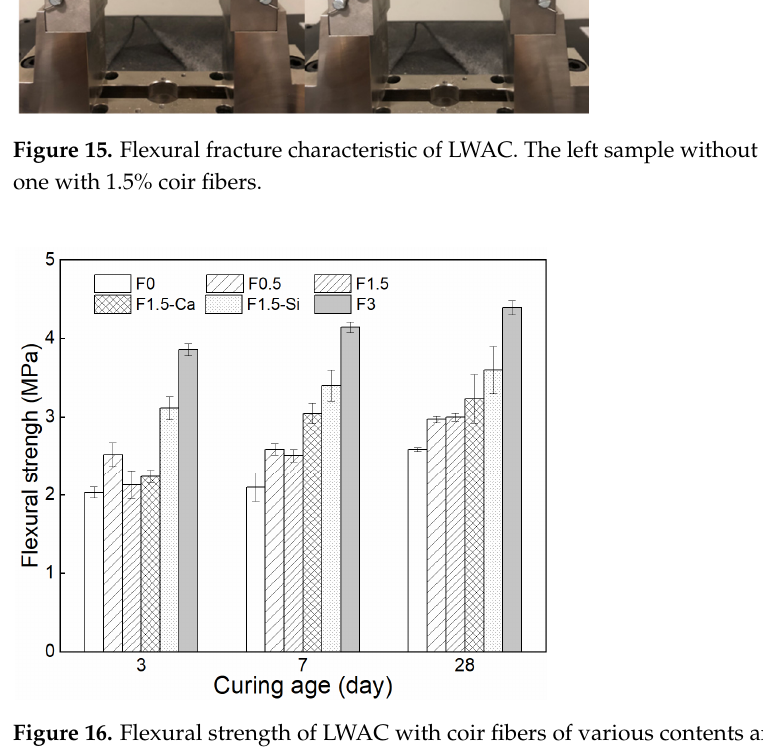
Figure 16. Flexural strength of LWAC with coir fibers of various contents and different treatments measured at 3, 7, and 28 days. The flexural toughness of each mixture at 28 days is shown in Figure 17. The tough- ness is significantly enhanced by increasing the amount of fibers. The toughness of the samples with 3% fibers shows about an 8 times increase from the reference samples. This is because the cracks extending acquires stretching, debonding, and breaking of fibers [71,75,77], during which it generates a considerable energy loss, contributing to increased fracture toughness. The toughness is slightly increased because of fiber treatments, which reveals that fiber content has a greater influence than treatments on the toughness. Even